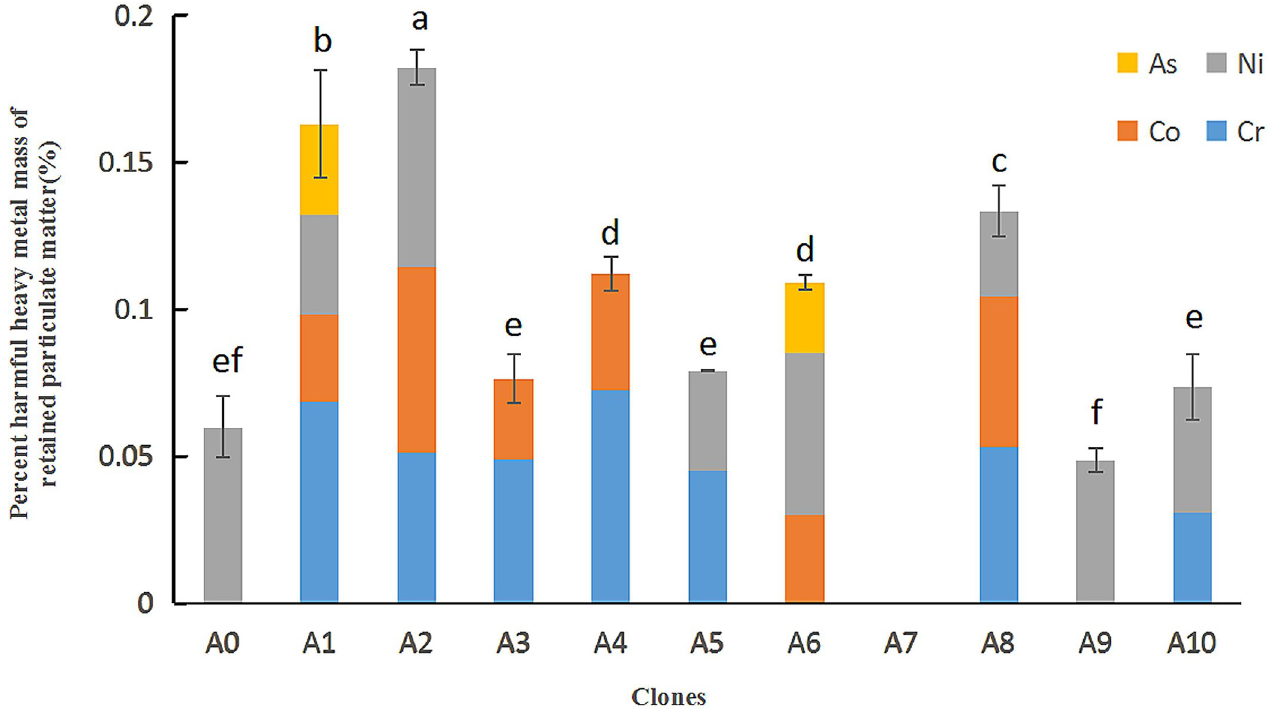
Fig 3. X-ray fluorescence (XRF) analysis of harmful heavy metals in particulate matter found on leaf surfaces.